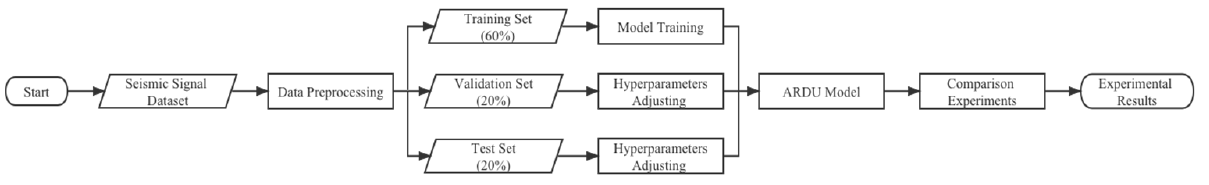
Figure 5. Basic experimental flow framework.